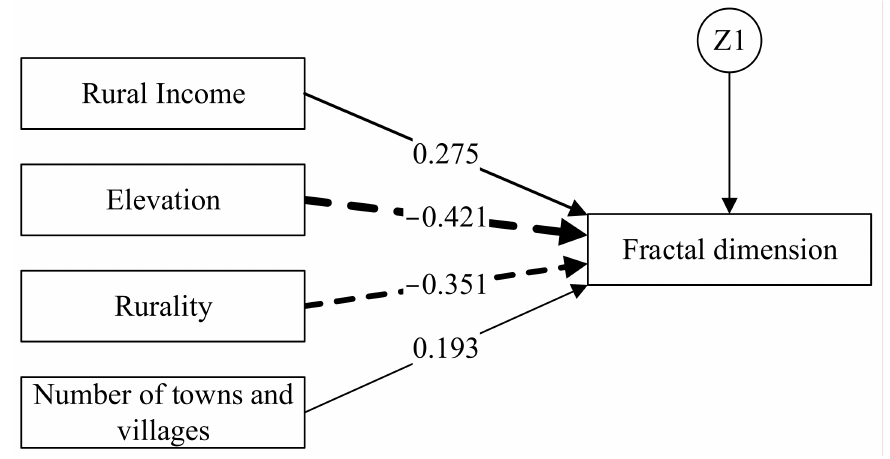
Figure 7. SEM model. Solid lines indicate positive effects, dashed lines indicate negative effects, and the width of the line indicates the magnitude of the